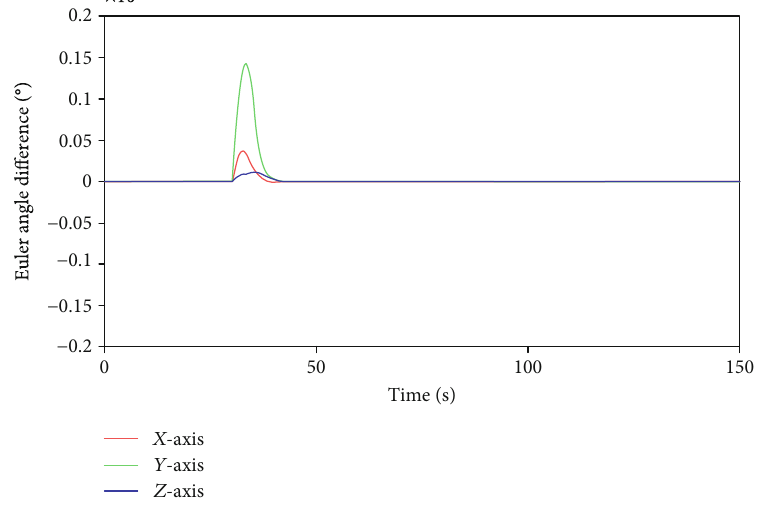
Figure 15: Impulse response of the neural network